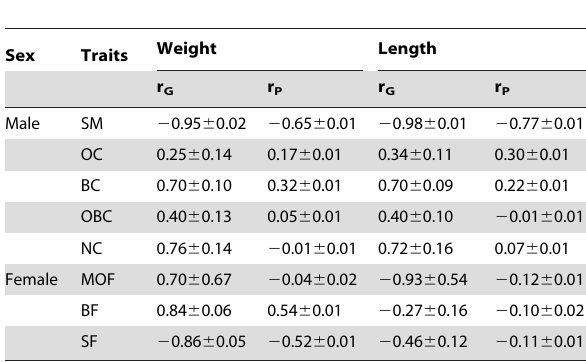
Table 7. Genetic (r G ) and phenotypic (r P ) correlations ( 6 s.e.) of male morphotypes and female reproductive statuses with production